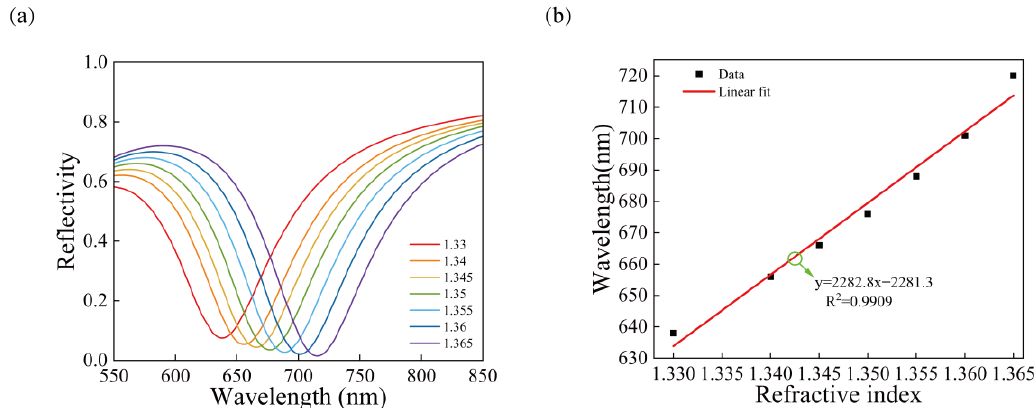
Figure 7. The reflectance curves of the Au array structure, ( a ) SPR curves for different refractive indices of the Au array structure, ( b ) relationship between the refractive index and the resonance wavelength and linear fitting.